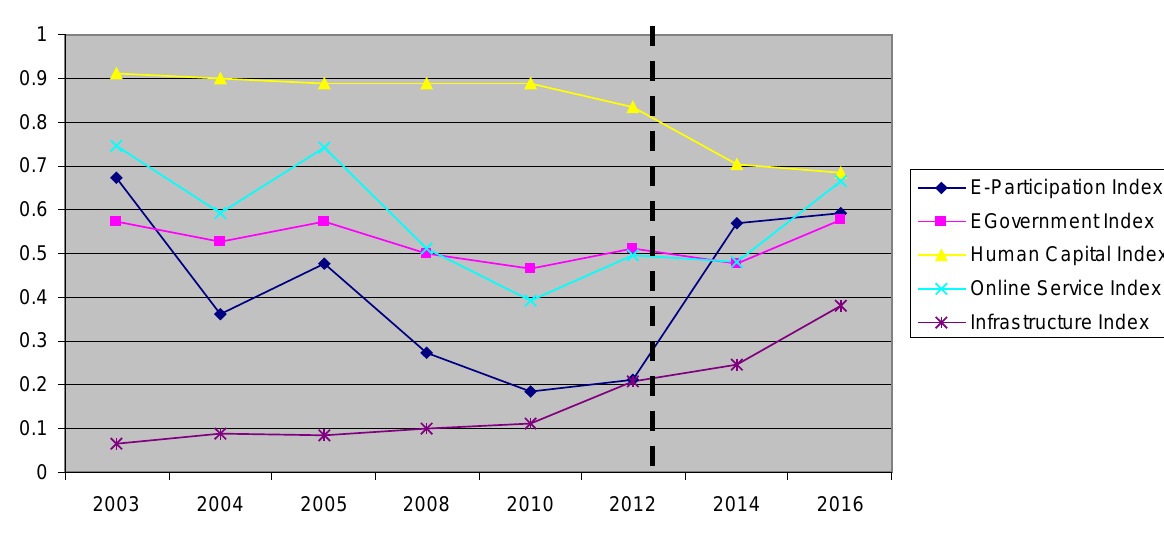
Figure 4: UN E-Government Survey Data for the Philippines (Source: UNPAN Data Center: https://publicadministration.un.org/egovkb/en-us/Data-Center, accessed: